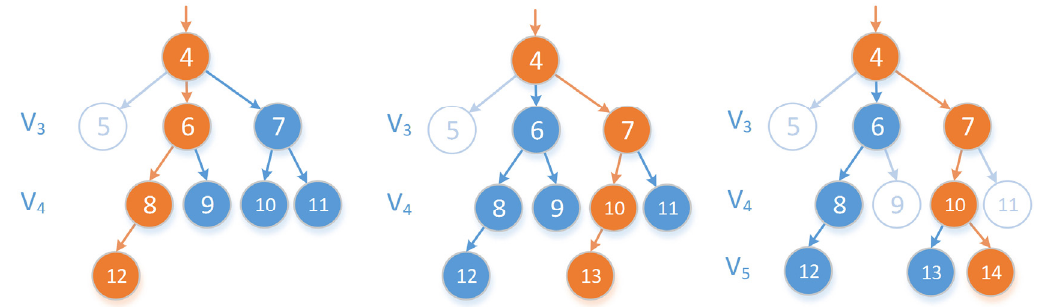
Figure 11. Running example of the output process.